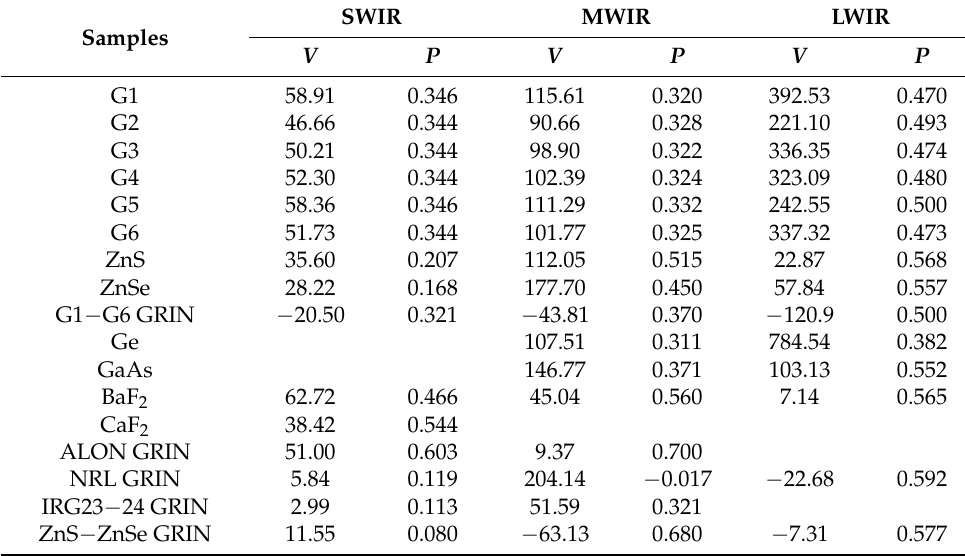
Figure 9. ( a ) Abbe number and refractive index trends for each band; ( b ) “P–V” diagrams of common infrared materials and GRIN material. Table 4. Abbe number (V) and dispersion (P) of common infrared and GRIN